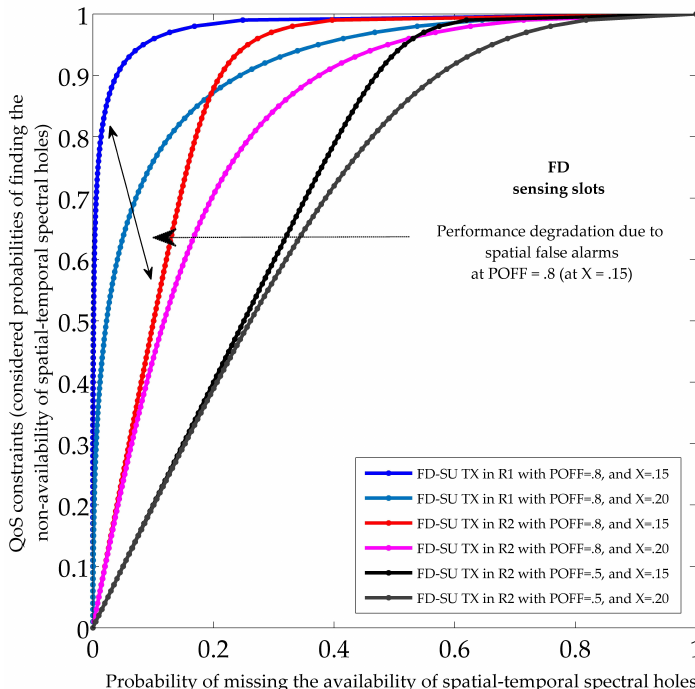
Figure 7. Sensing performance of spatial–temporal spectral holes during the full duplex (FD) sensing